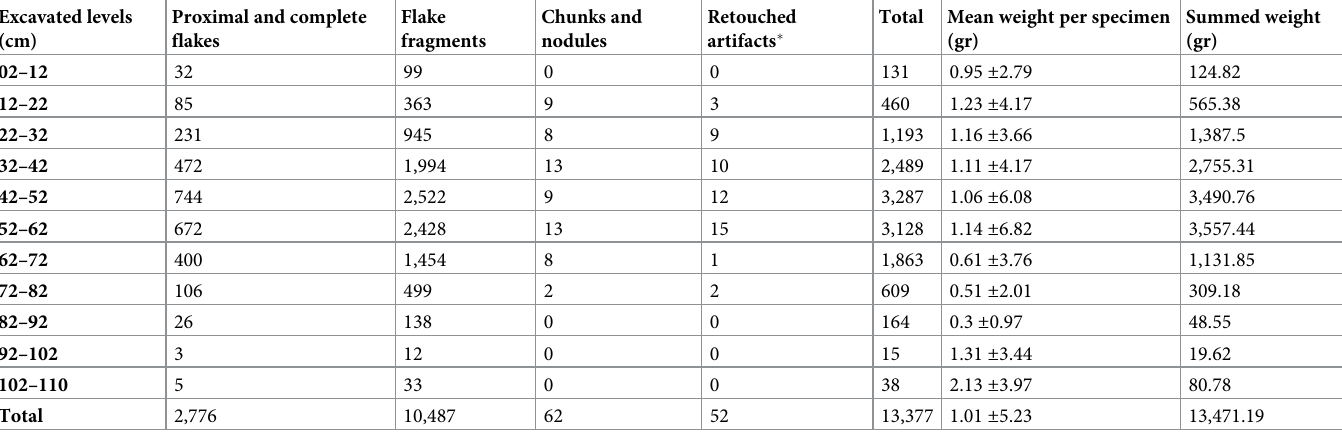
Table 2. Summarized frequencies of the lithic